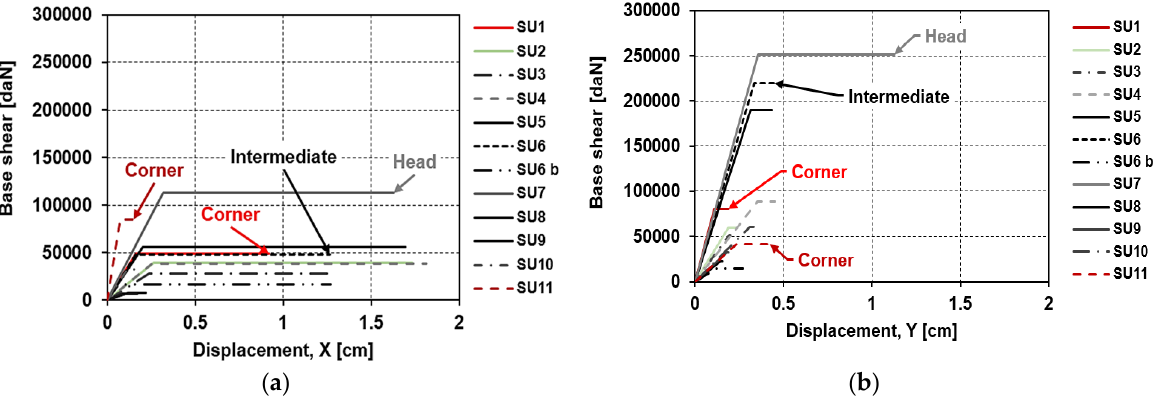
Figure 11. Bilinear curves for the selected SUs in X ( a ) and Y ( b ) analysis directions. From the acquired results, it appears that the behaviour of the SUs in the two analysis directions is quite heterogeneous. In particular, the head units have been denoted with black-grey, the corner units in red, and a black scale colour has been adopted for the other intermediate units. The capacity parameters expressed in terms of forces and displacements for each of the analysed SUs are presented in Table 4.